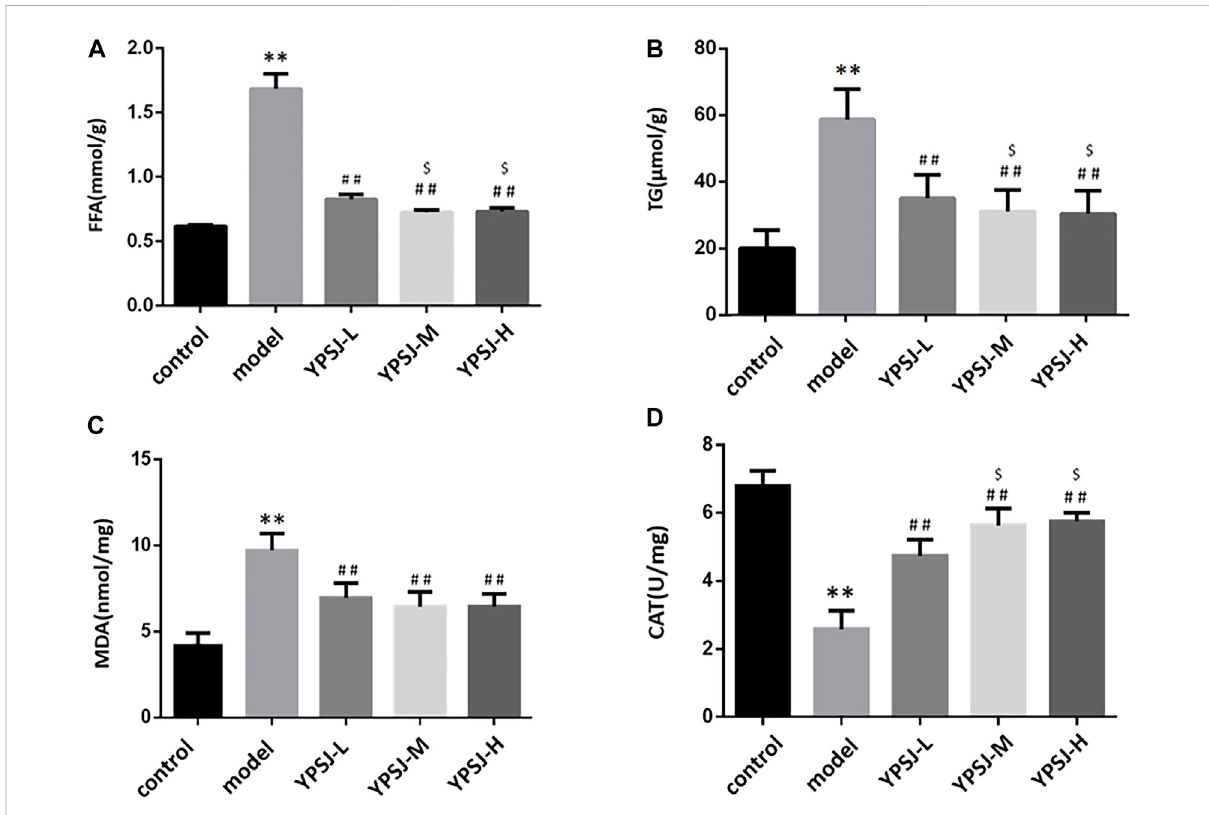
FIGURE 3 Comparisonofmyocardialfreefattyacid(FFA)andtriglyceride(TG)levelsineachgroupofrats (A,B) ;Comparisonofmyocardialmalonaldehyde (MDA) and catalase (CAT) levels in each group of rats (C,D) ; ** p < 0.01 vs. control group; ## p < 0.01 vs. model group; $ p < 0.05 vs. YPSJ-L